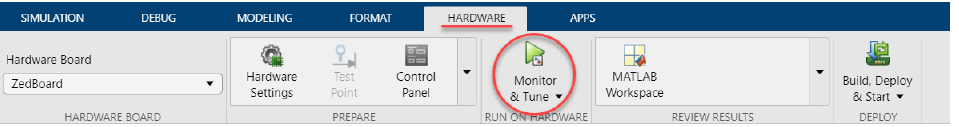
Figure 10. Simulink menu interface for external mode